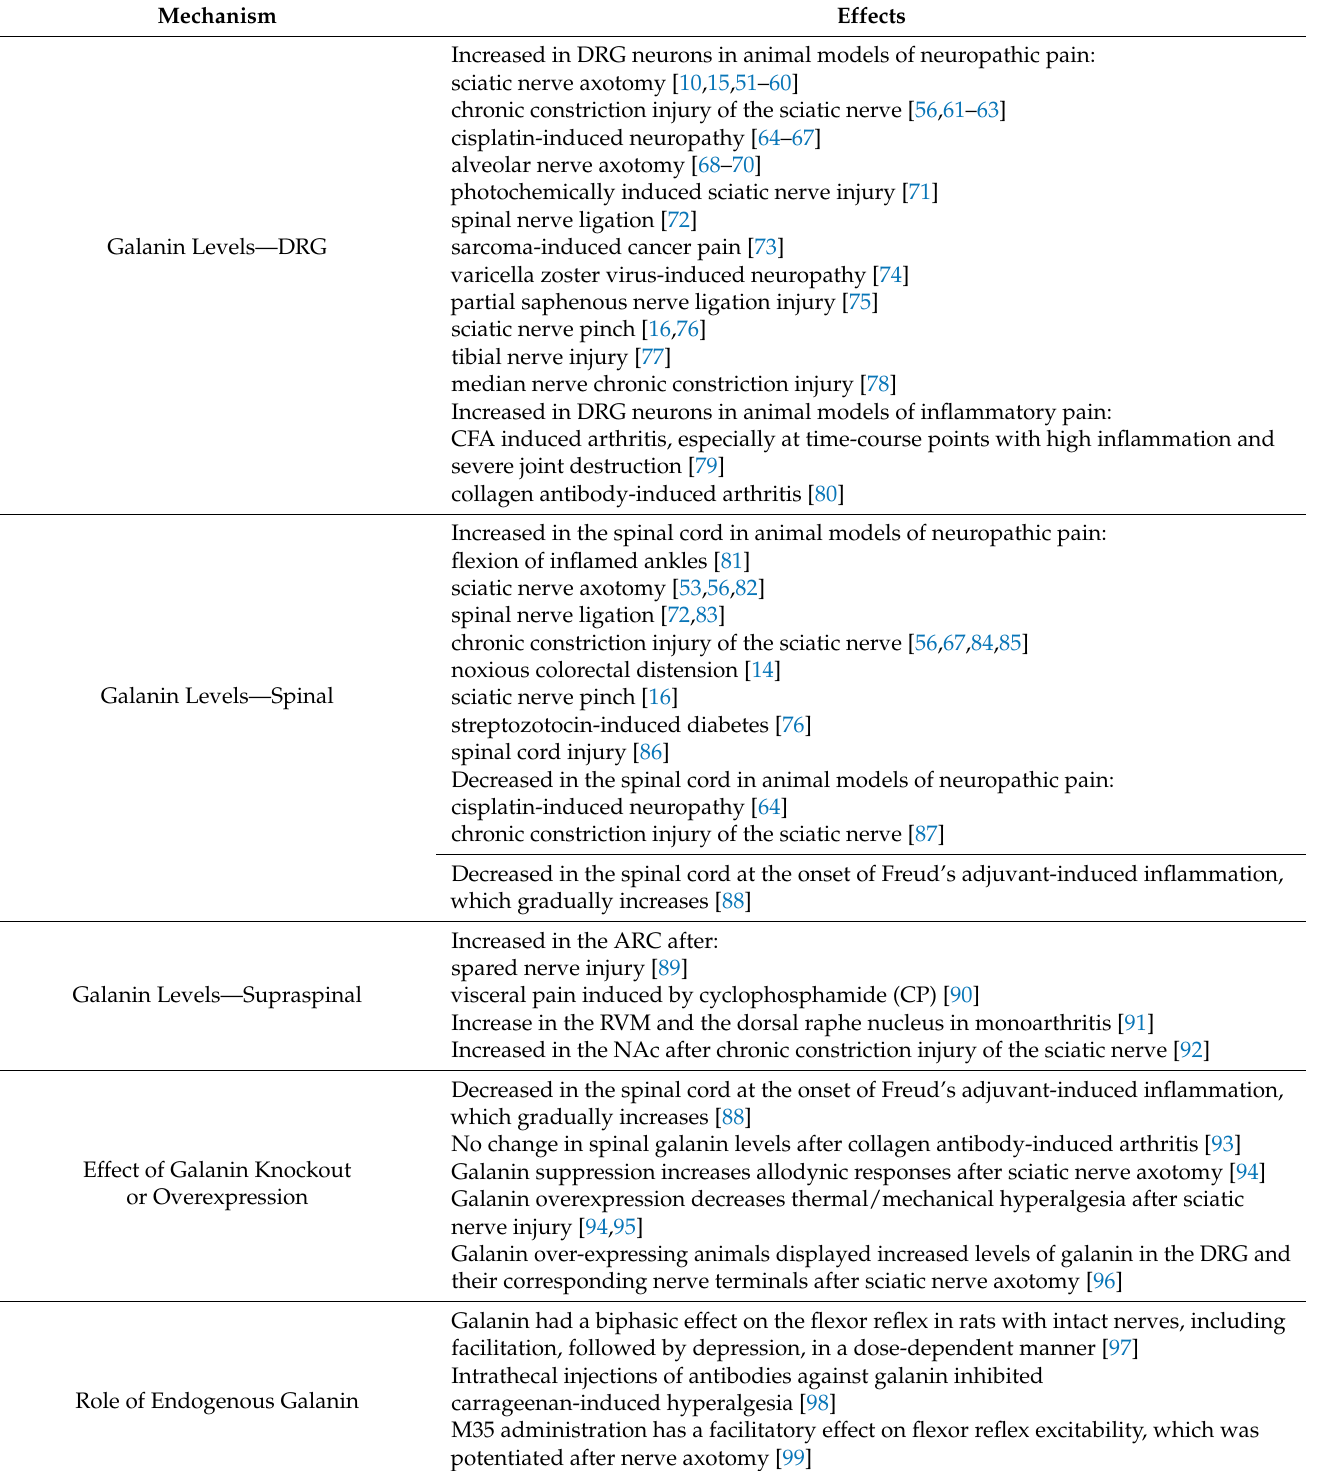
Table 2. Summary of the literature search on the role of galanin and its receptors in different animal models of experimental pain. (ACC—anterior cingulate cortex; ARC—arcuate nucleus of